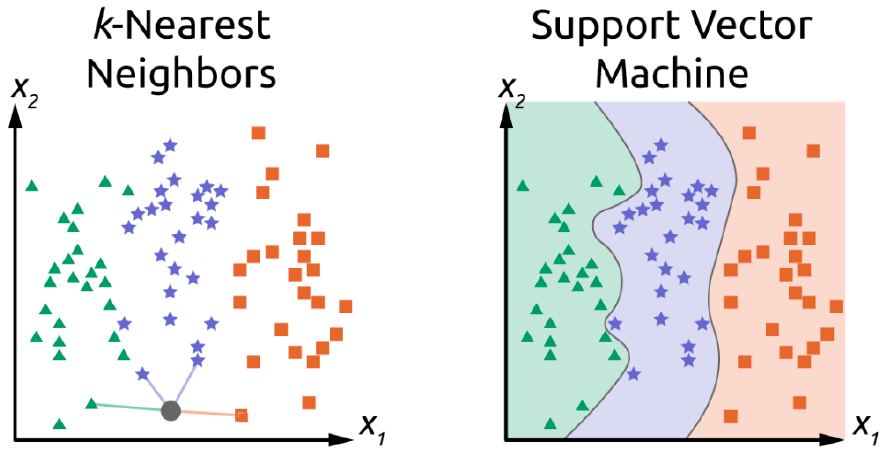
Figure 1. Comparison of classification technique using k -NN and SVM. In k -NN, four nearest neighbors are shown contributing to the gray point’s assignment. Classification of the gray point is the blue star class. In hypothetical SVM with nonlinear kernel, new data are classified in which region the point lies. In both examples, the feature space consists of two dimensions. Classification could be, for example, bacterial species like E. coli , Salmonella spp., Pseudomonas spp., Staphylococcus spp., Enterococcus spp., etc. In practical applications, the feature space has many more dimensions, where decision boundaries for SVM are hyperplanes in the ( n − 1) dimension for an n -dimensional feature vector.